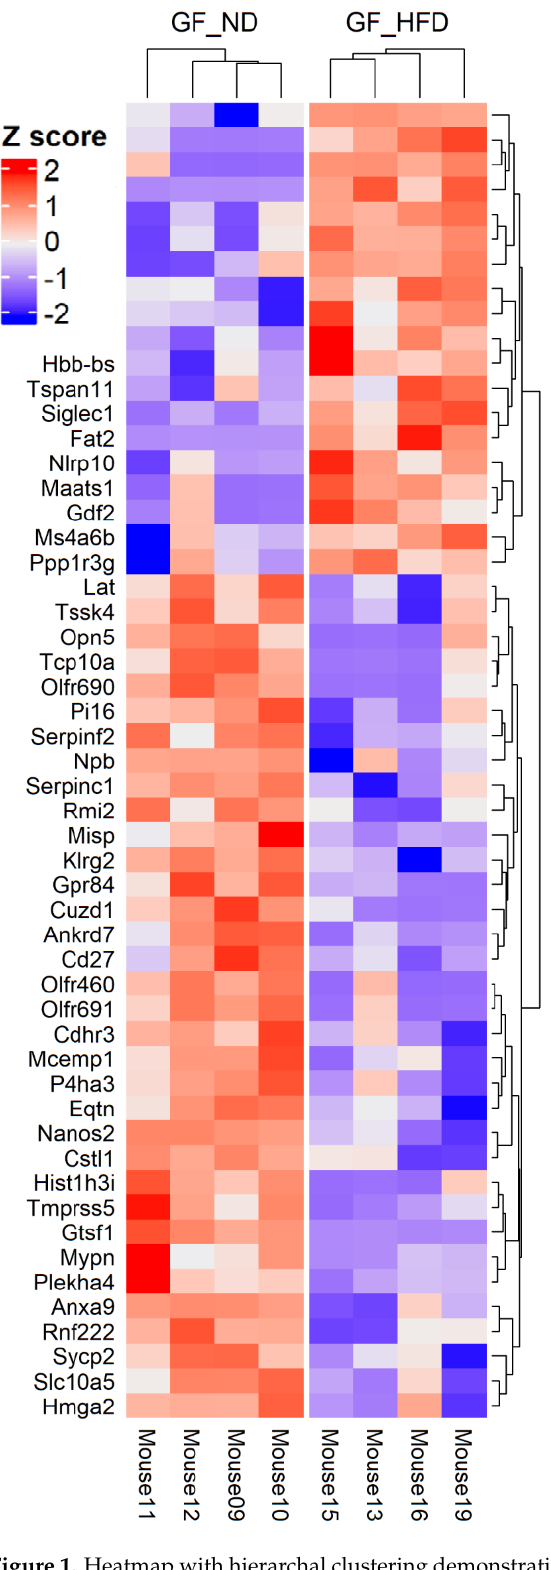
Figure 1. Heatmap with hierarchal clustering demonstrating 53 differentially expressed genes (DEGs) with a logFC greater than 1 and p -value < 0.01 between germ-free mice on normal diet (GF-ND, n = 4) and germ-free mice on high-fat diet (GF-HFD, n = 4). Z-score is calculated from LogFC with red and blue indicating upregulated and downregulated genes, respectively.